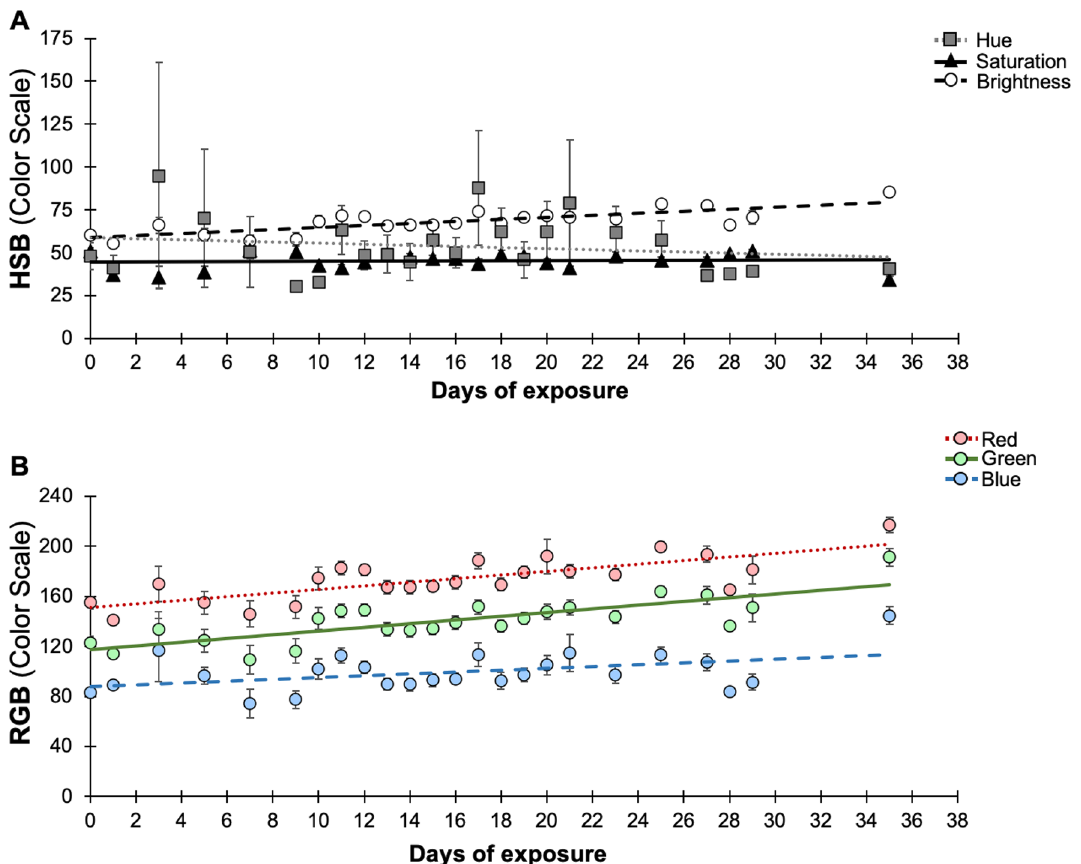
(Phase I: exposure in days). Color scales (HSB and RGB) are pooled across species. Error bars represent SE of the